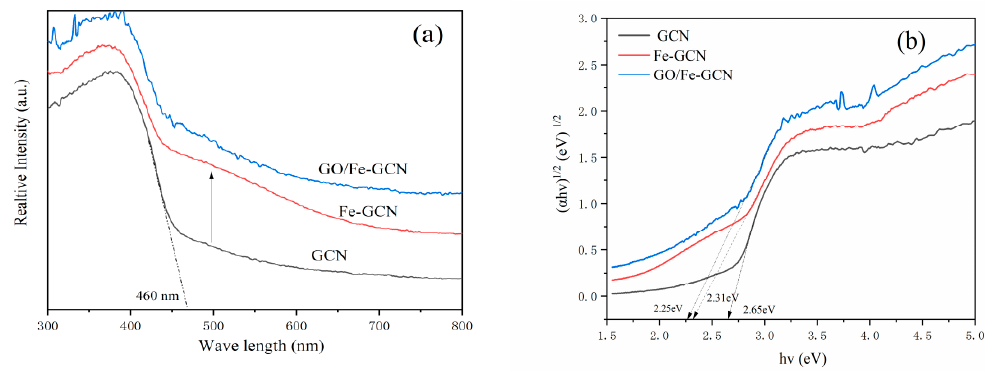
Figure 4. UV-vis DRS patterns ( a ) and band-gaps ( b ) of GCN, Fe-GCN, and GO/Fe-GCN.